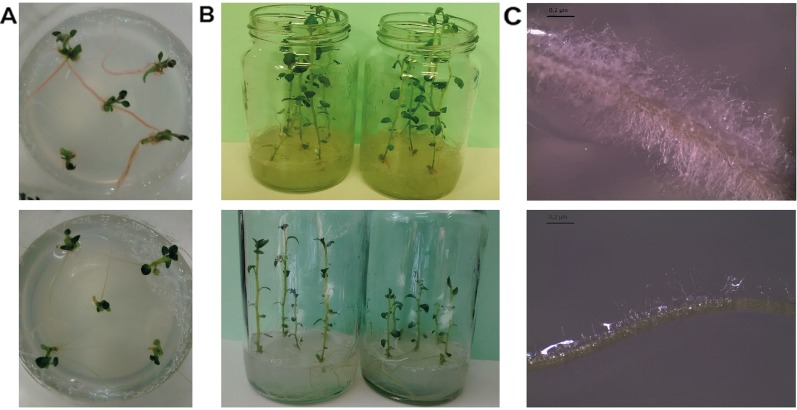

Methylobacterium sp. 2A was found associated with roots of potato plants established in vitro.
(A) Bacterial pink-pigmentation was evident in the roots of one-week-old potato plants. Five-weeks-old plants associated with Methylobacterium sp. 2A exhibited increased growth (B) and increased root hair density (C). Plants not associated with Methylobacterium sp. 2A that were micropropagated simultaneously are shown in lower panels as reference. Bar: 0.2 µm.